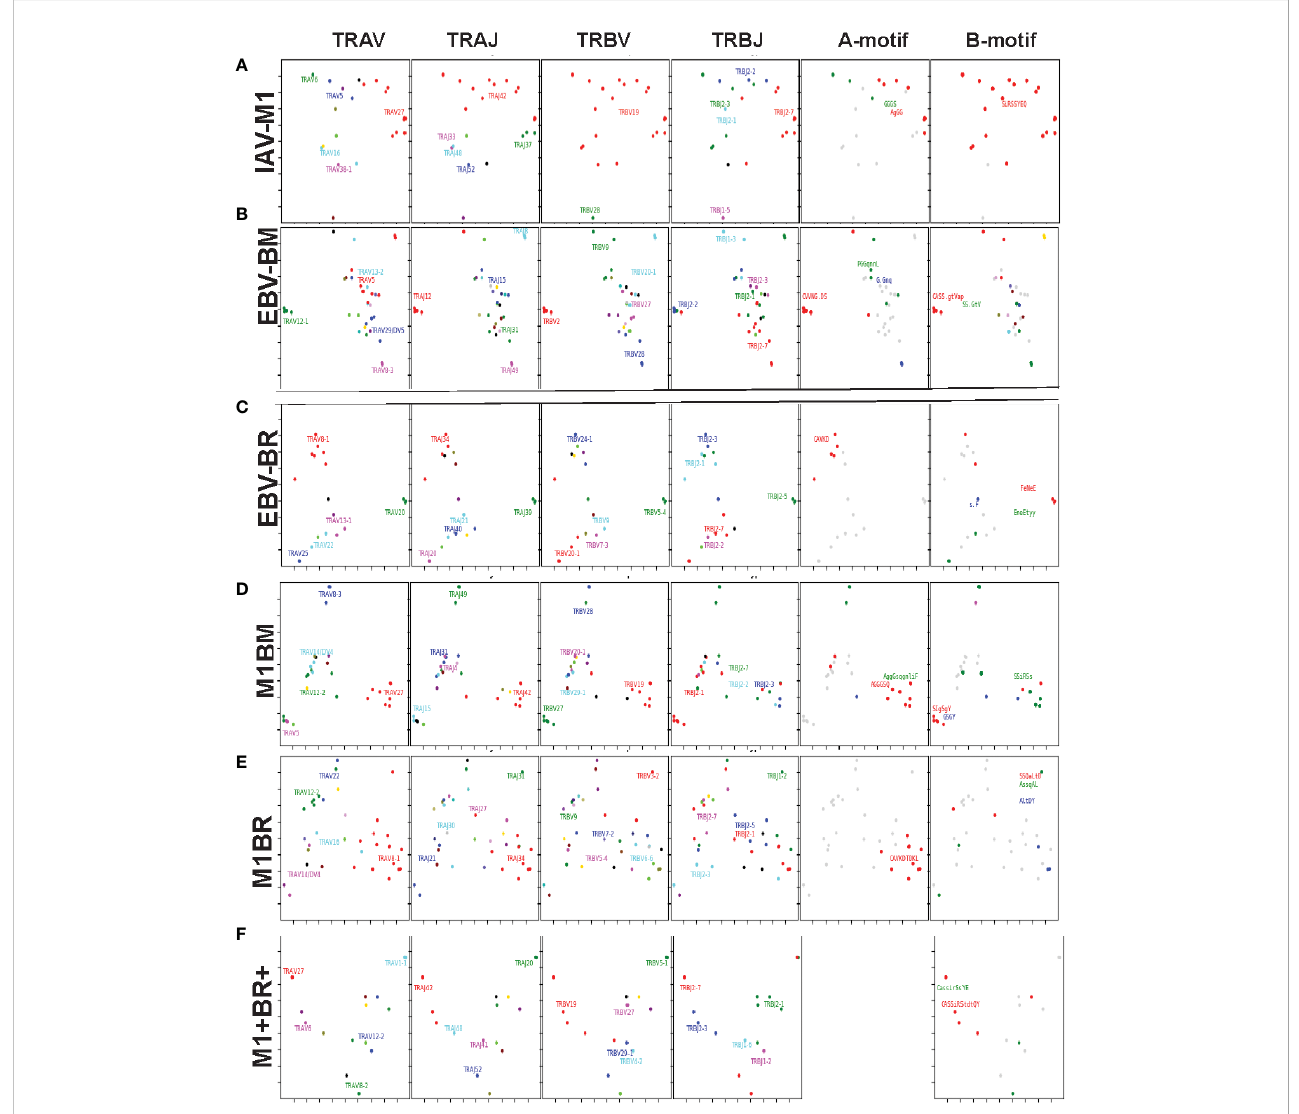
FIGURE 10 Kernel Principle Components Analysis of single cell TCRab sequencing shows that the cross-reactive populations differ from cognate, at times using combinations of TCR features speci fi c for the two different ligands (A – F) . Tetramer-sorted single cell CD8 T cells from representative Y and O donors were transcribed into cDNA, then ampli fi ed AV/AJ and BV/BJ gene combinations using primers from a published multiplex PCR technique (6, 8). TCR single cell sequencing data was combined from Y and O donors (Y, n=2; O, n=2). Kernel Principal Components Analysis (kPCA) 2D projection plots were used to show the AV/AJ/BV/BJ pairing of the single analyses (6). Each point on the plot represents a single TCR clone, the location of the clone is based on TCRdist measurements which place similar TCR clones closer together on the 2D plot. Each clone can be tracked to determine the gene usage and pairing by the color and location. Each of the four gene segments, TRAV, TRAJ, TRBV, and TRBJ (left to right) has a separate plot. The last two plots, represent the CDR3 motif generated for TRAV/AJ and TRBV/BJ genes. (for details on sequences see Tables 1 and